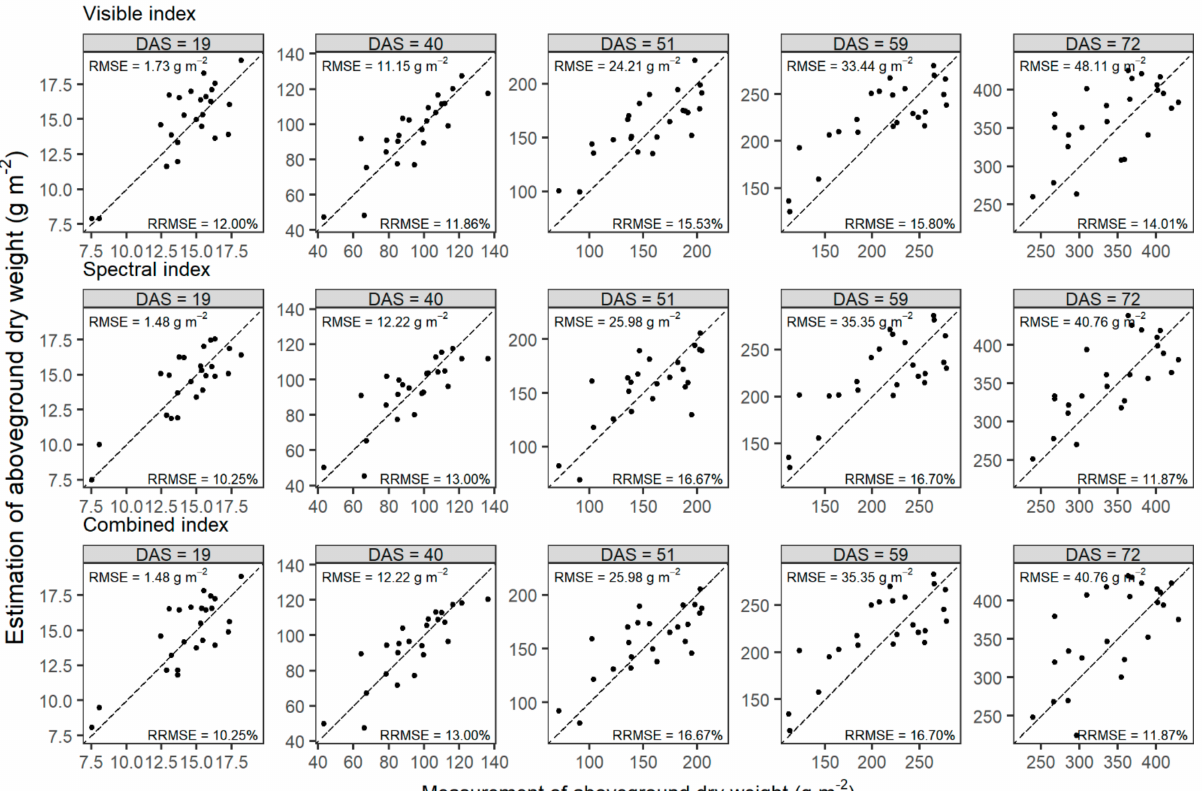
Figure 6. Comparisons of measurements and estimates of aboveground dry weights of wheat in the testing set at five prediction dates (represented by days after sowing, DAS) before flowering. Aboveground dry weights were estimated by PLSR models, which were built using the mono-temporal datasets of visible, spectral, and combined indexes at prediction dates, respectively. Dashed lines are one-to-one